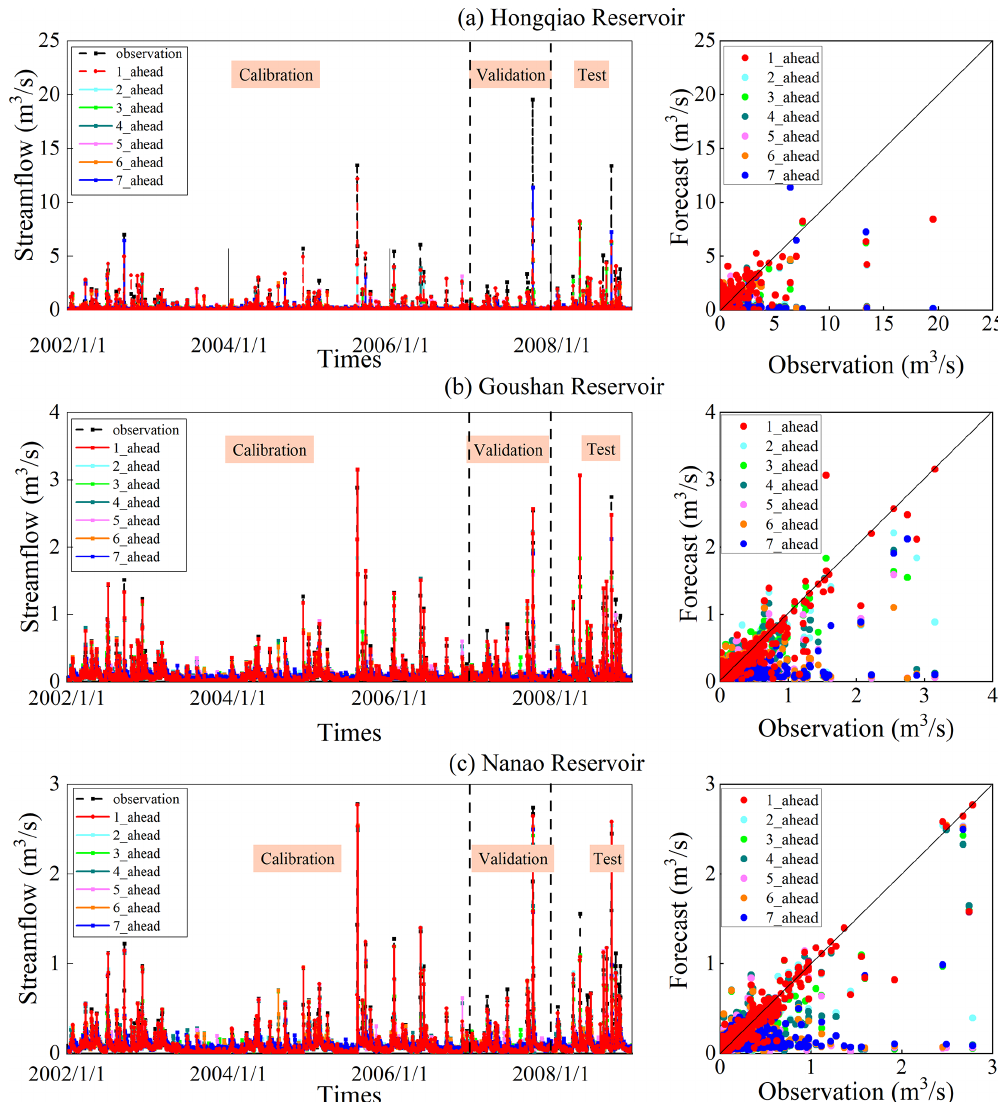
Figure 10. Forecast results of (a) Hongqiao, (b) Goushan, and (c) Nanao reservoirs under S3.